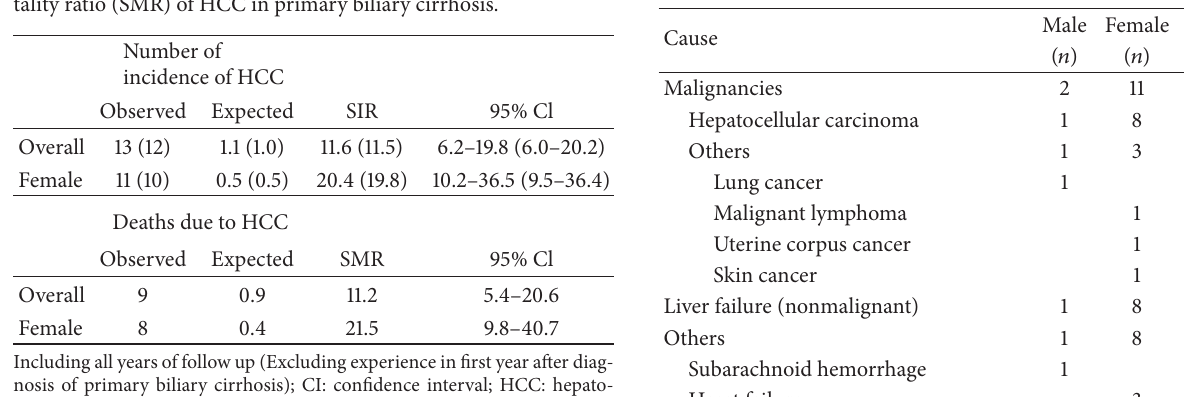
Table 4: Primary cause of